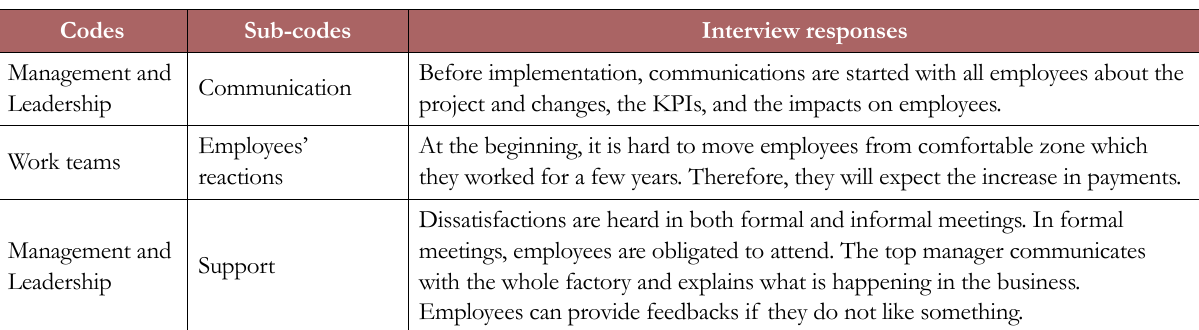
Table 3. Quotes of interviews related to dimension